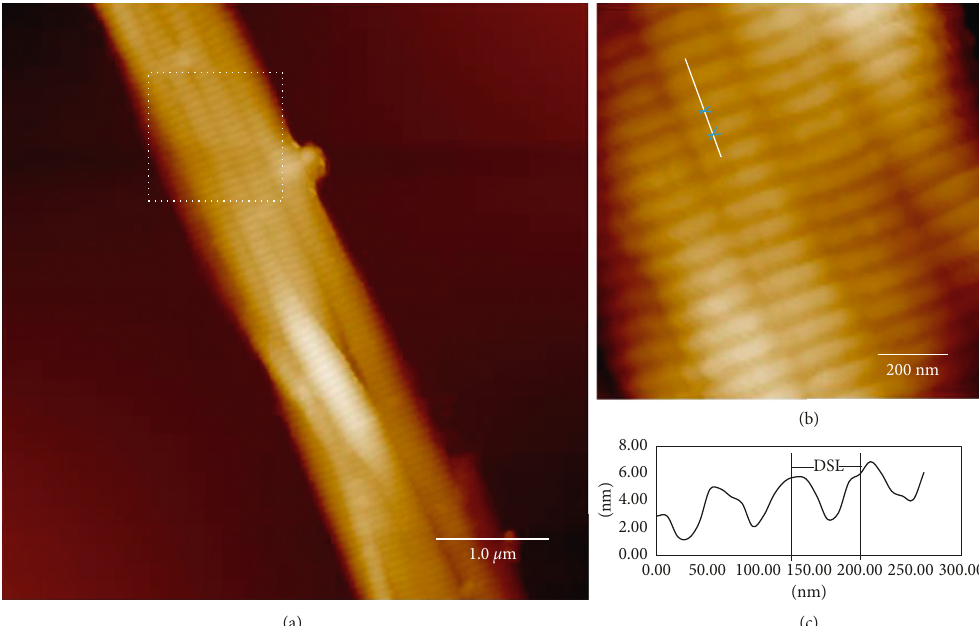
Figure 1: Typical AFM height images of collagen fibrils. (a) Control group, (b) partial amplification of white dotted line in (a), and (c) section analysis profile of collagen fibrils along the white line.